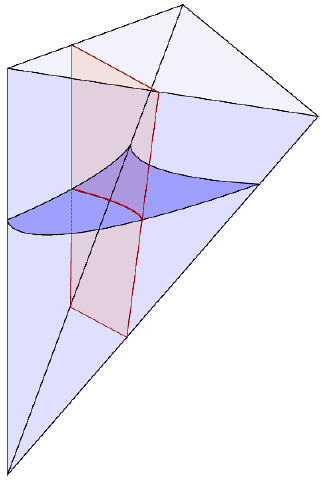
Figure 1 . Pictorial representation of a K(cid:127)ahler cone with h 1 ; 1 = 3 parametrised by the 2-cycle vol- umes t i . The hypersurfaces of (2.10) are represented respectively in blue and red. The intersection between these two hypersurfaces inside the cone represents the reduced moduli space M r